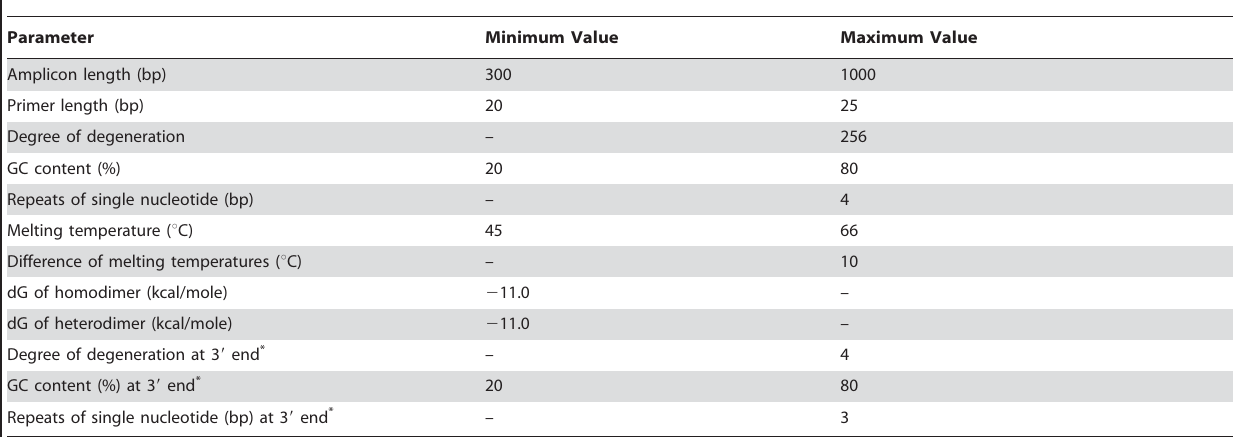
Table 1. Oligonucleotide PCR primer design parameters.